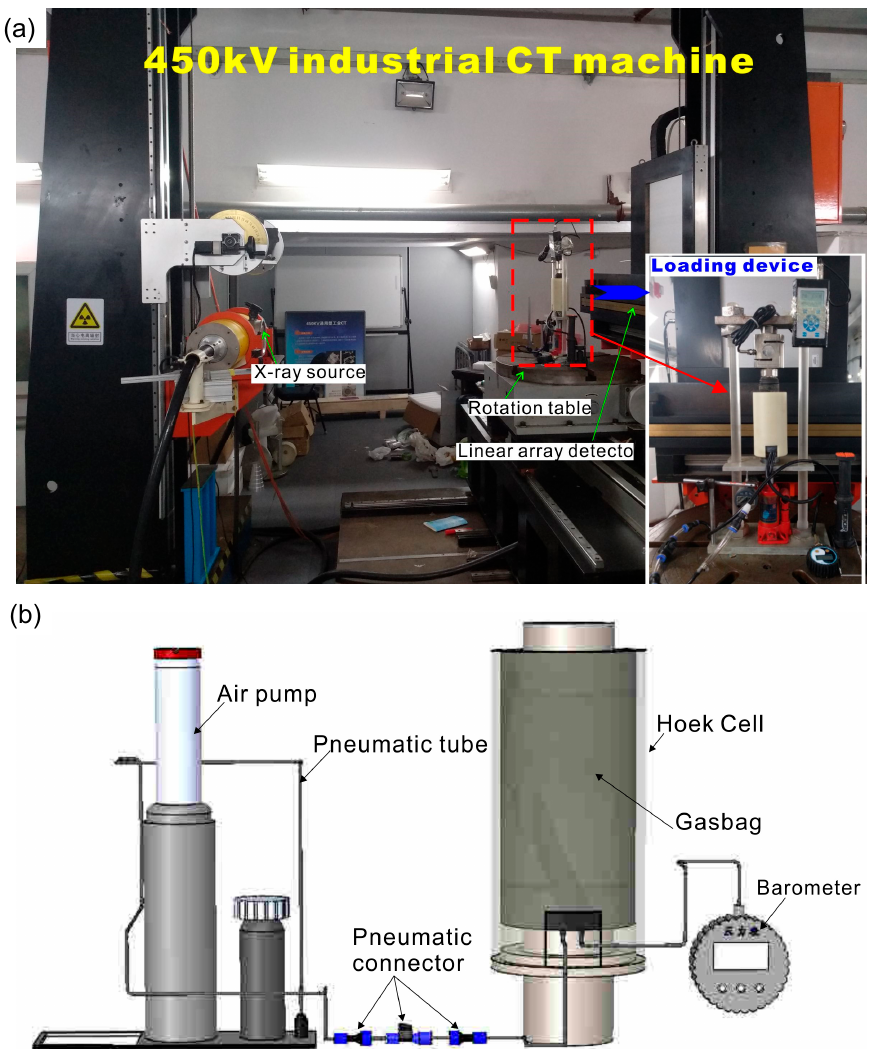
Figure 5. The experimental system of real-time CT scanning for the CWRTB samples. ( a ) X-ray CT machine and loading device; ( b ) scheme of the gasbag Hoek cell.